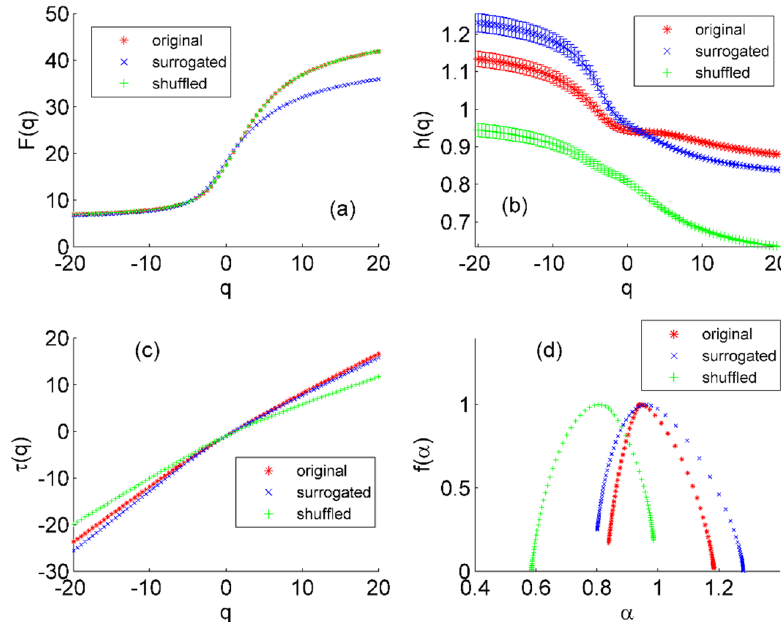
Fig. 7 Plots comparing the original, surrogated, and shuf- fled Planetary K -index time series a F ( q ) versus q , b h ( q ) versus q , c 𝜏 ( q ) versus q , d f ( 𝛼 ) versus